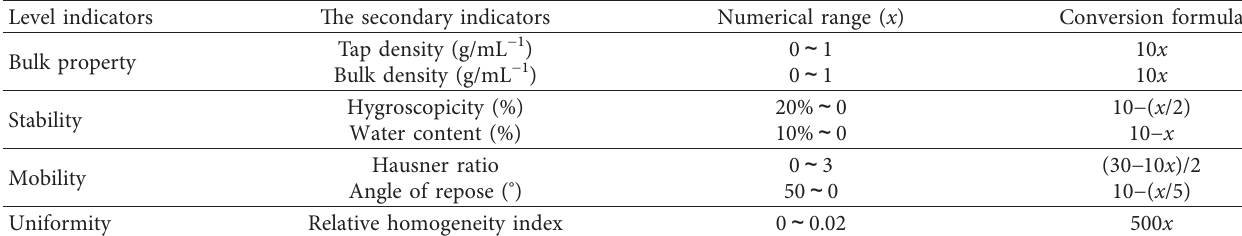
Table 7: Standardized conversion method of secondary physical